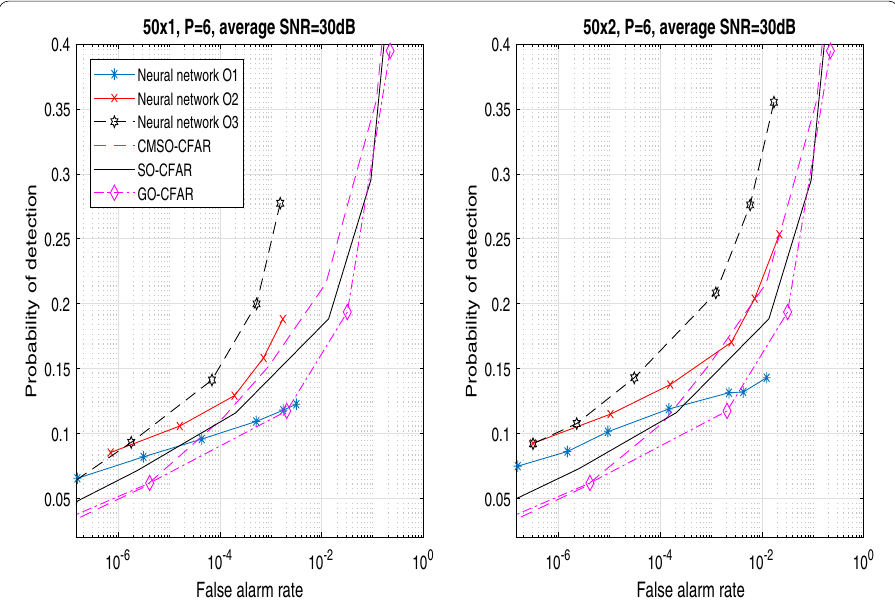
Fig. 7 Receiver operating characteristic curves, noise-only